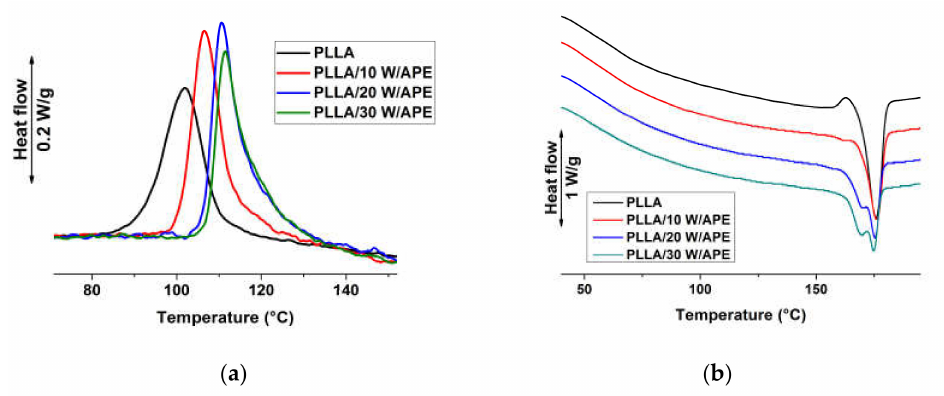
Figure 2. Heat flow rate plots of PLLA and PLLA / wood composites of the indicated compositions upon cooling at 5 K / min ( a ) and upon subsequent heating at 10 K / min ( b ). Exotherm upward.